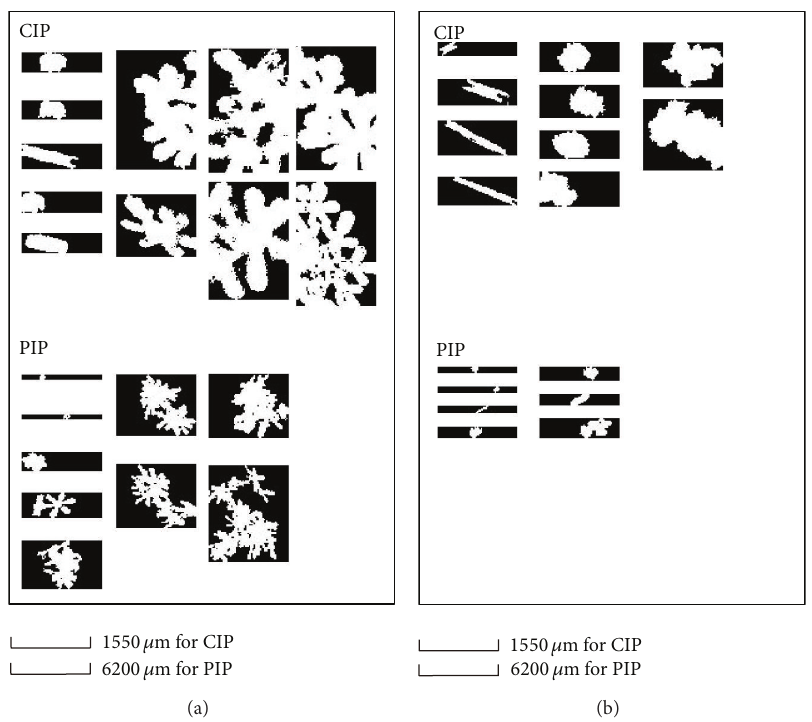
Figure 3: CIP and PIP images across flight leg 1 during (a) 1031–1035 CST and (b) 1044–1046 CST.